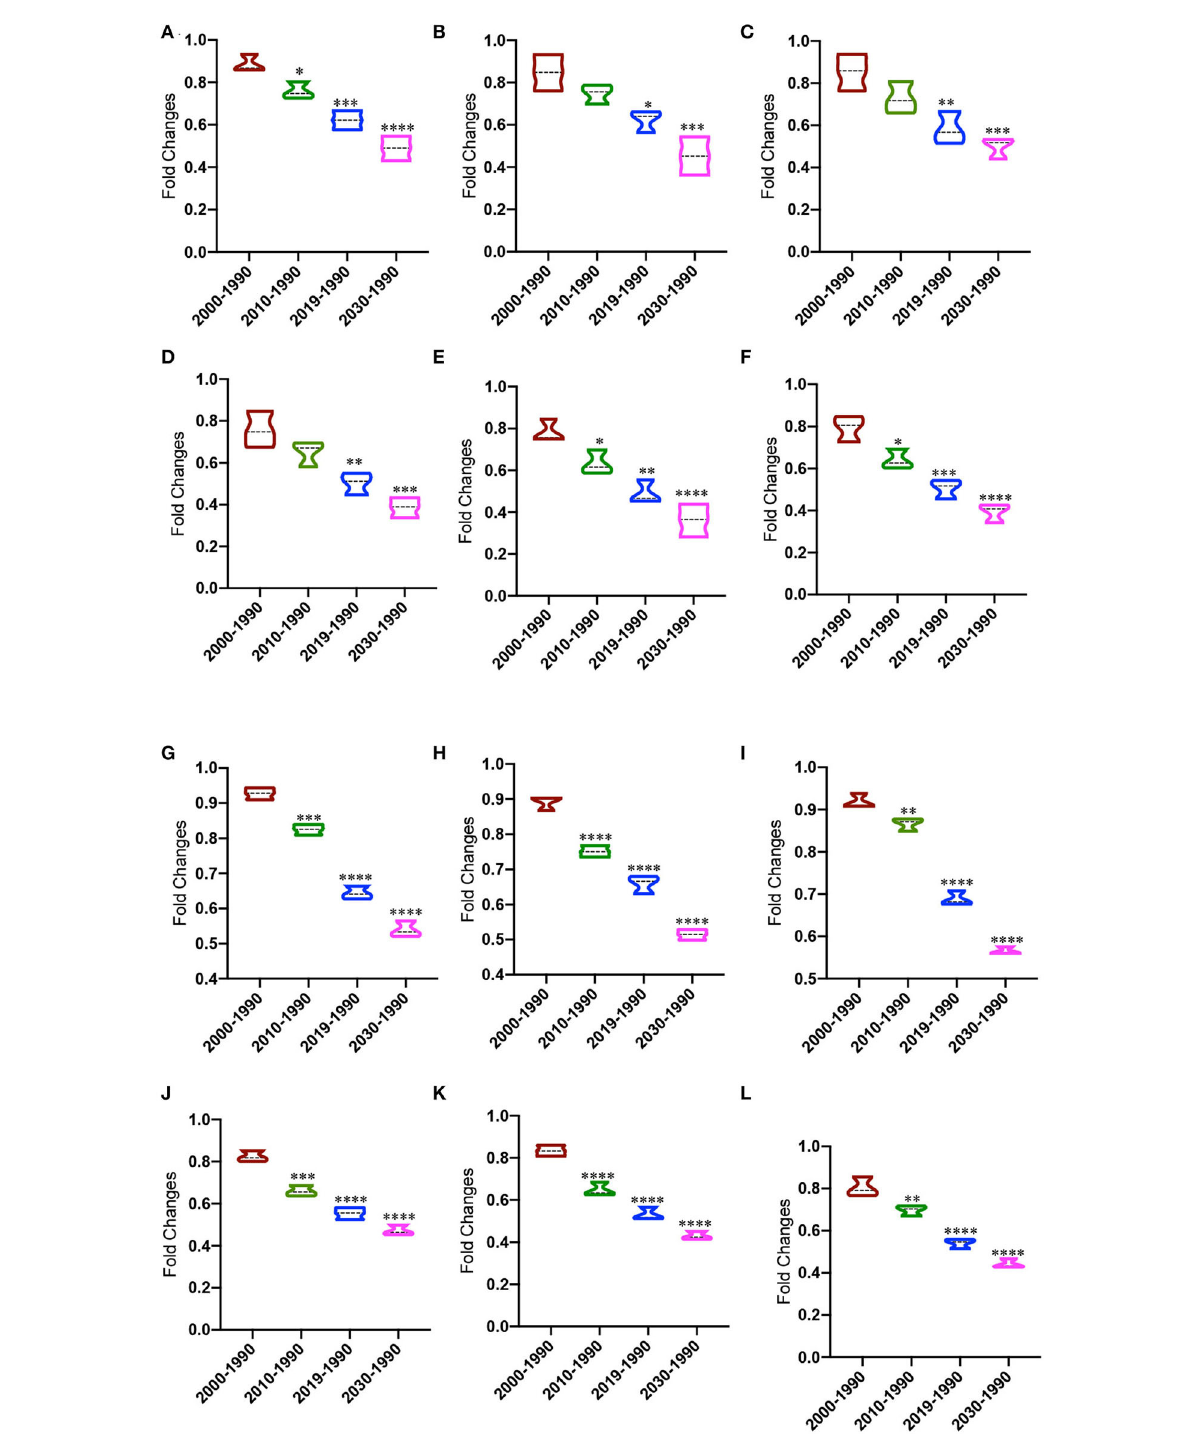
FIGURE2 The changing trend of ASD and DALYs from 1990 to 2030. (A) The fold changes of ASD number of both genders. (B) The fold changes of ASD number of males. (C) The fold changes of ASD number of females. (D) The fold changes of ASD rate in both genders. (E) The fold changes of ASD rate in males. (F) The fold changes of ASD rate in females. (G) The fold changes of DALYs number in both genders. (H) The fold changes of DALYs number in males. (I) The fold changes of DALYs number in females. (J) The fold changes of DALYs rate in both genders. (K) The fold changes of DALYs rate in males. (L) The fold changes of DALYs rate in females. * P < 0.05, ** P < 0.01, *** P < 0.001, and **** P < 0.0001 vs. 2000–1990